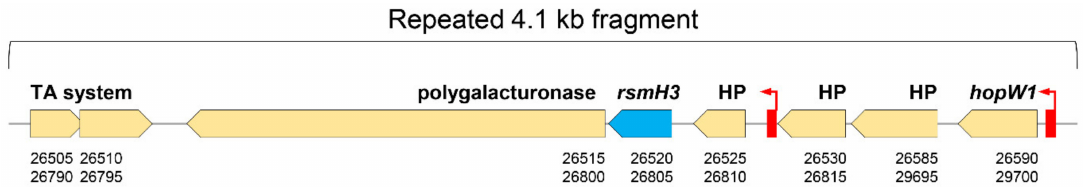
Figure 3. Gene rsmH3 is located within a duplicated fragment in plasmid p1448A-A from P. amygdali pv. phaseolicola 1448A. Coding sequences are depicted as block arrows, with that of rsmH3 highlighted in blue, and with numbers at the bottom indicating the PSPPH_RS locus tag for each of the two copies (accession no. NC_007274). TA system indicates a putative toxin–antitoxin system of the RelE / ParE family; polygalacturonase, is a glycoside hydrolase family 28 protein; HP, hypothetical protein; hopW1 is a type III secretion system e ff ector that contributes to the virulence of Pph 1448A [71]. The red boxes show the location and orientation of promoters regulated by HrpL ( hrp boxes)